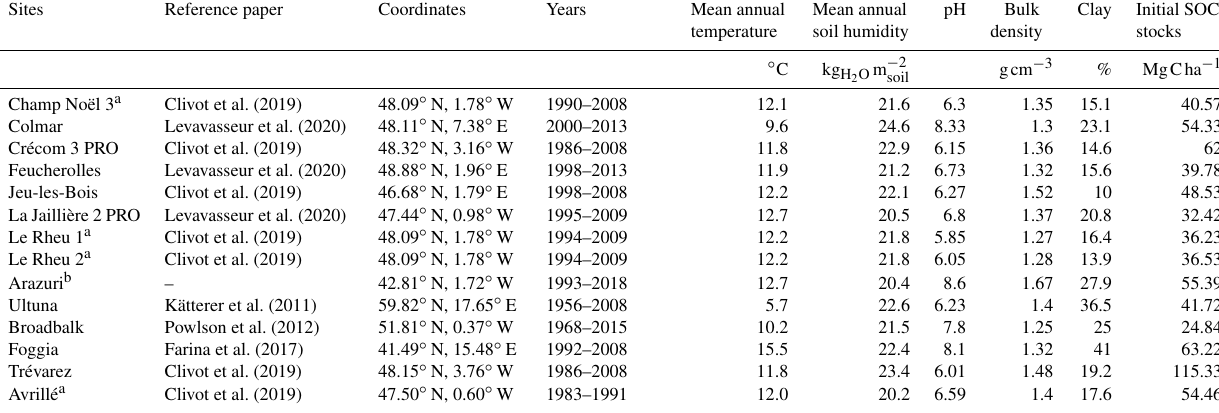
Figure 1. Location of the 60 field trials distributed among the 14 cropland experiments around Europe. Table 2. Information about experimental sites, including mean annual values of temperature ( ◦ C) and soil humidity to approximately 20cm depth (kg H m − 2 ) simulated with the ORCHIDEE model at each experimental site, measured pH, bulk density (gcm − 3 ), clay (%) and soil 2 O initial SOC stocks in the control plots (MgCha − 1 ) at the experimental sites. Reference papers for each site are indicated. Sites Reference